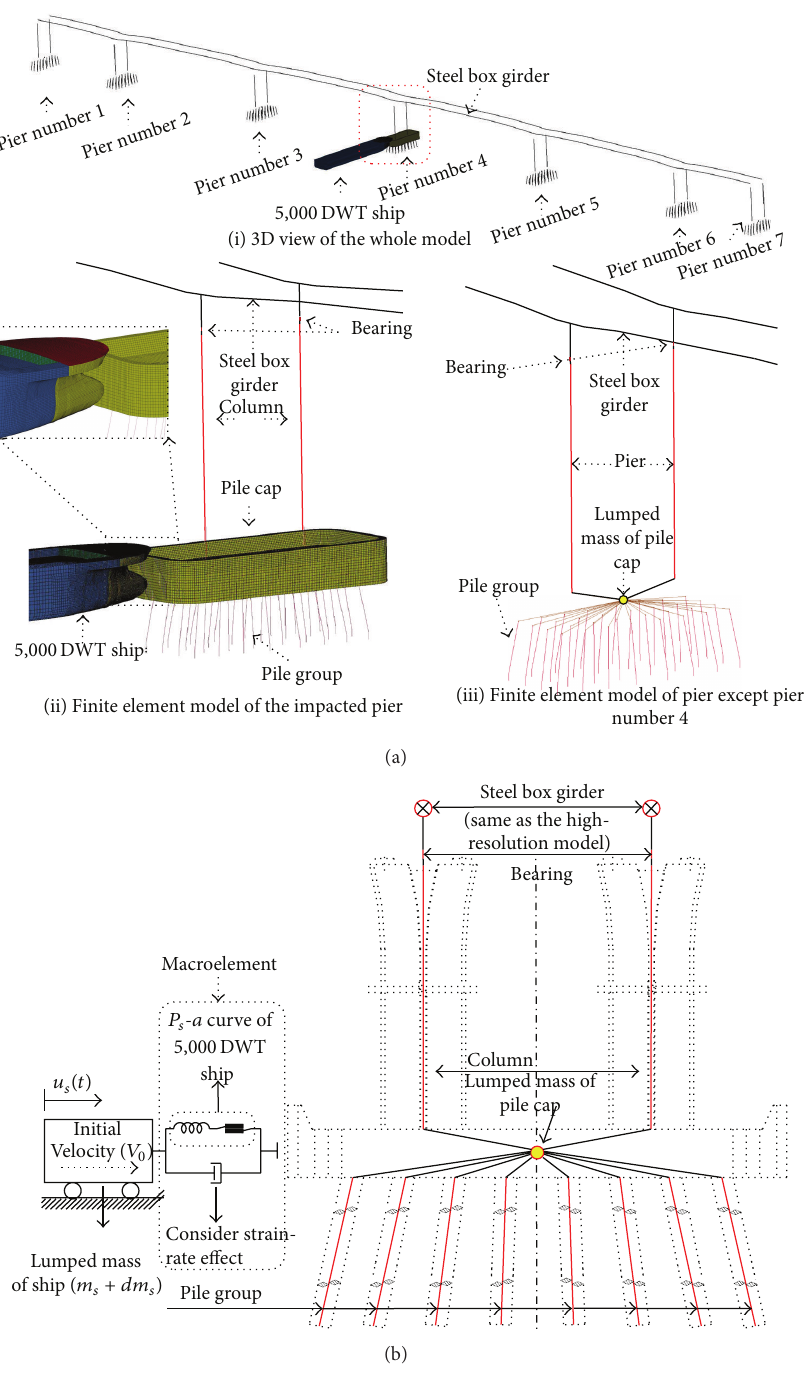
Figure 19: (a) High-resolution model of ship-bridge collision; (b) Macroelement model using the developed P-a curves and equations.